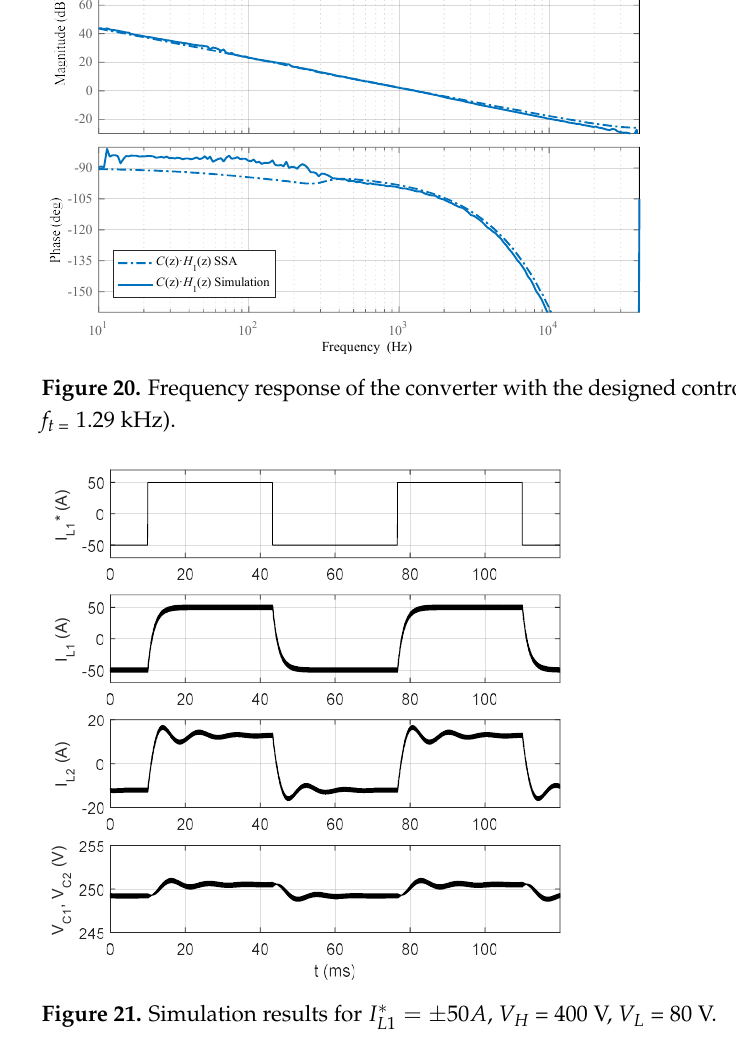
H = 400 V, V L = 80 V. Figure 21. Simulation results for